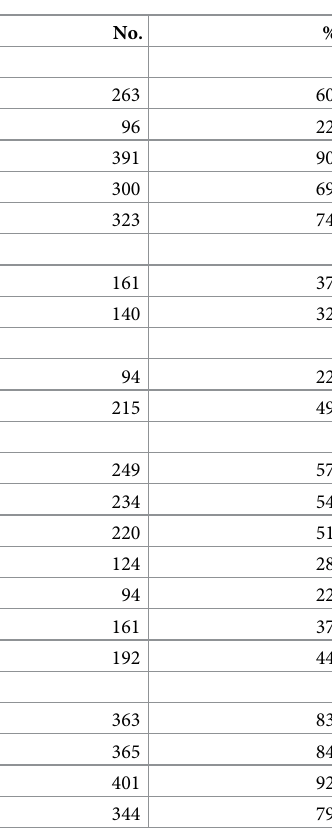
Table 1. Distribution of TB patients’ well-being in different